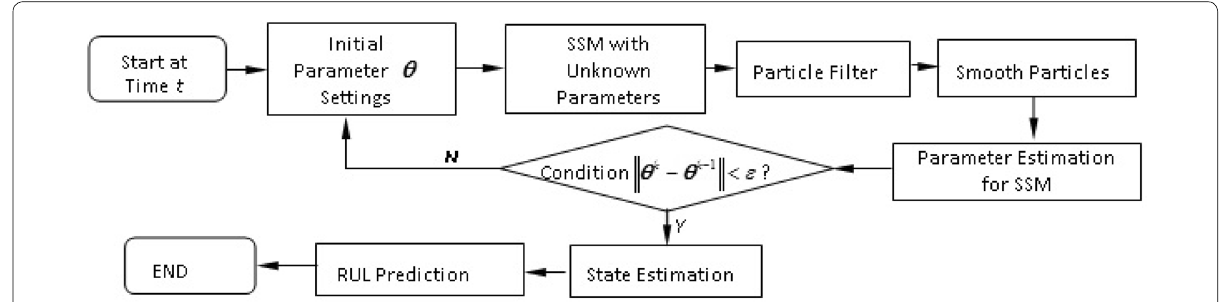
Figure 3 Flow chart of the methodology of the remaining life